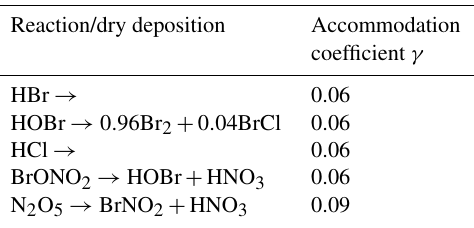
Table A5. Heterogenous reactions and dry depositions occurring on the ice/snow